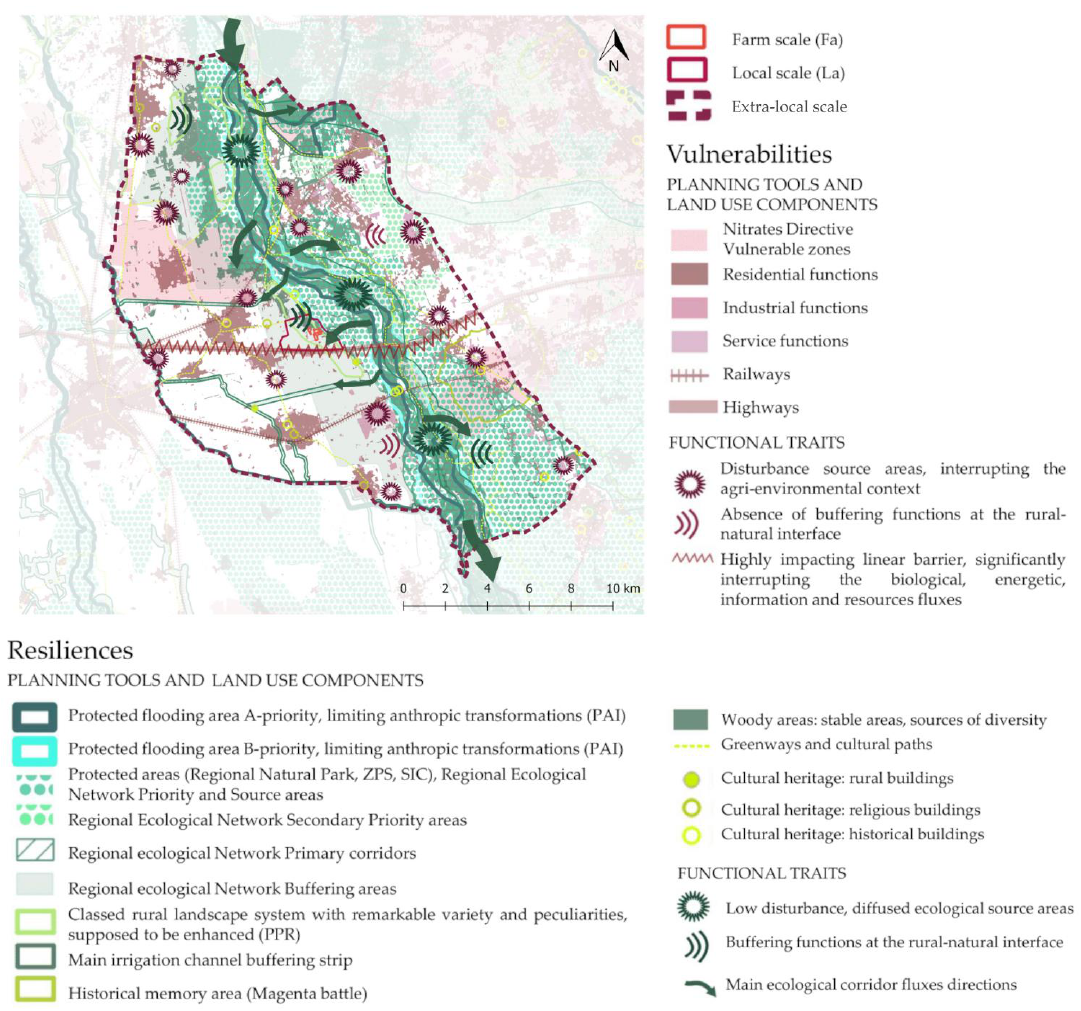
Figure 2. Extra-local scale VR analysis.